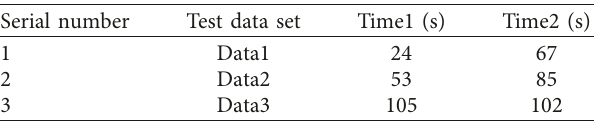
Figure 4: Implementation framework of logistics information intelligent analysis based on cloud association mining. Table 1: Experimental comparison